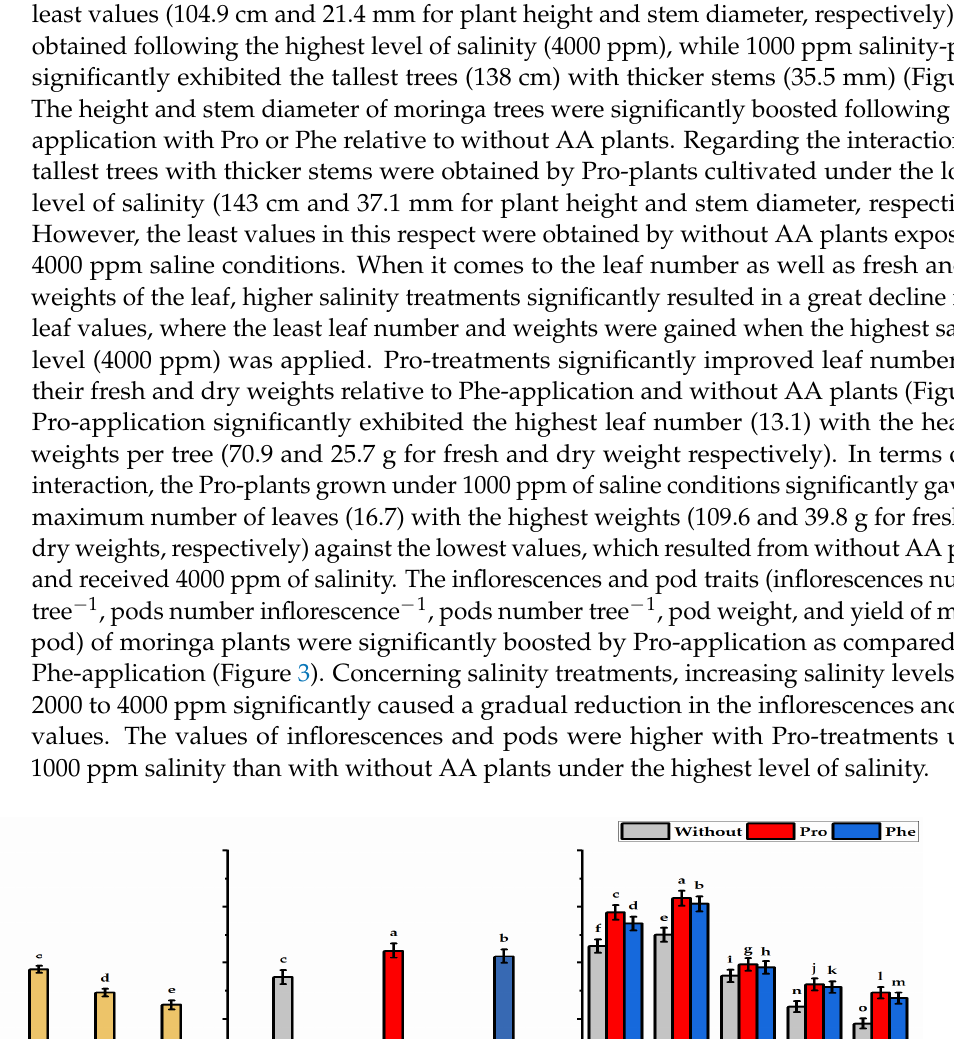
Figure 2. Influence of exogenous spray treatments of proline (Pro) or phenylalanine (Phe) on ( A ) leaves number, ( B ) leaves fresh weight, and ( C ) leaves dry weight tree − 1 of moringa trees cultivated